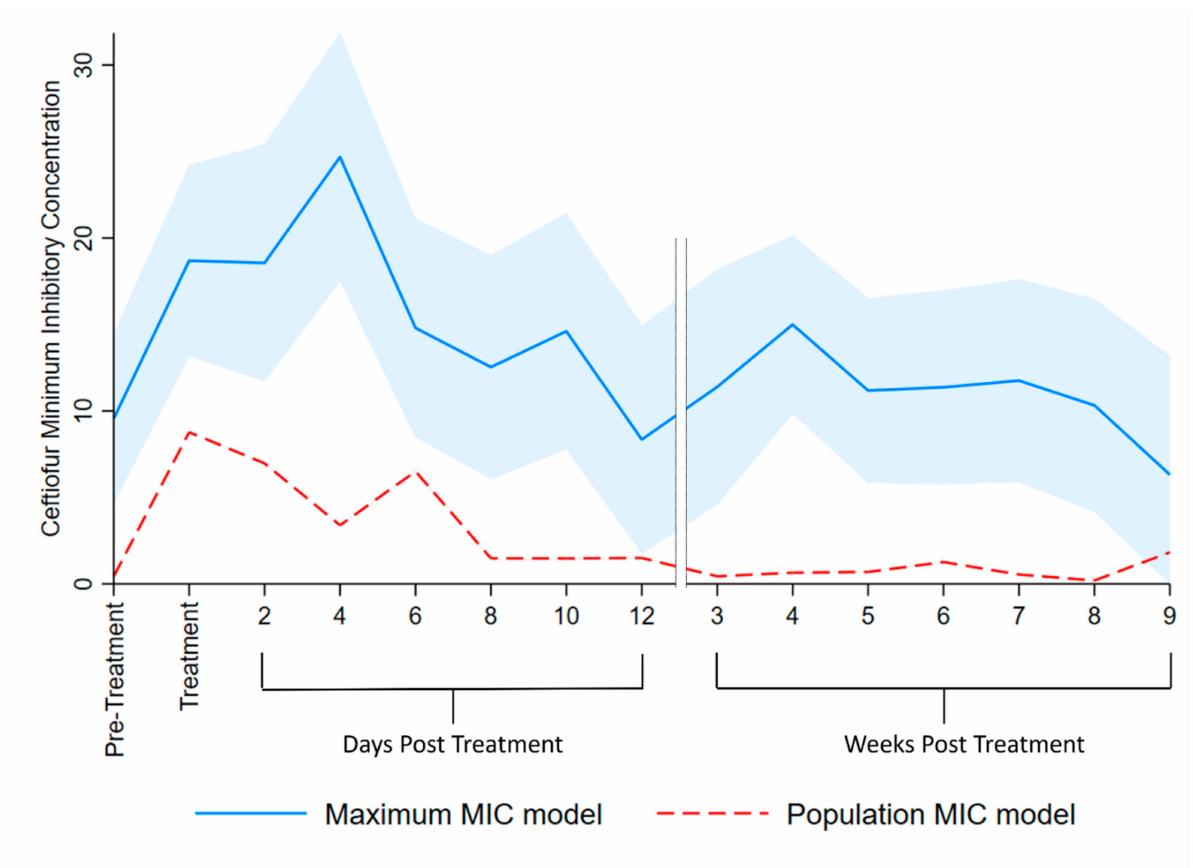
Figure 4. Multilevel mixed effect interval regression analysis for ceftiofur MIC of Enterobacteriaceae estimates. The Maximum MIC model interval data lower limit was determined by the greatest ceftiofur concentration that permitted growth and the upper limit by the lowest ceftiofur concentration that inhibited growth, per cow per sample day. The shaded area represented the 95% confidence interval for the maximum MIC model. The Population MIC model data was determined by estimating the interval-censored total number of colonies/g of feces for each interval of ceftiofur concentration observed, per cow per day. The 95% confidence intervals are censored for the population MIC model as the large count of colonies per cow per day results in too narrow